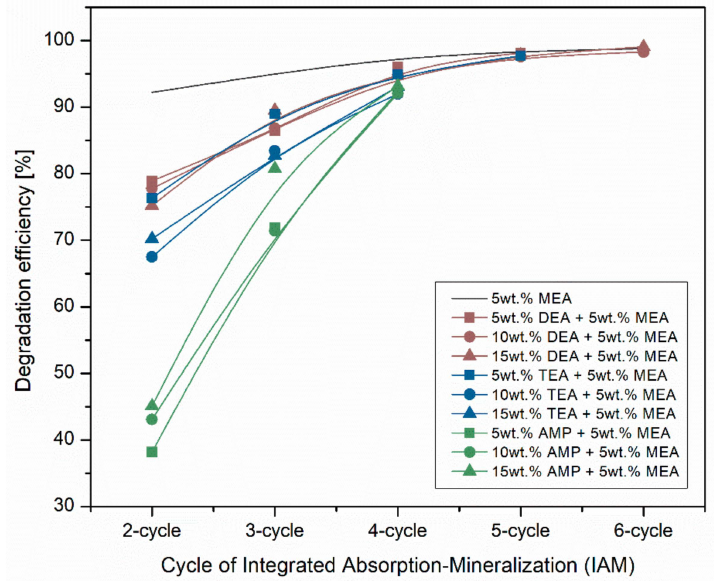
Figure 5. Degradation efficiency of blended alkanolamine absorbents in multicycle integrated absorption–mineralization